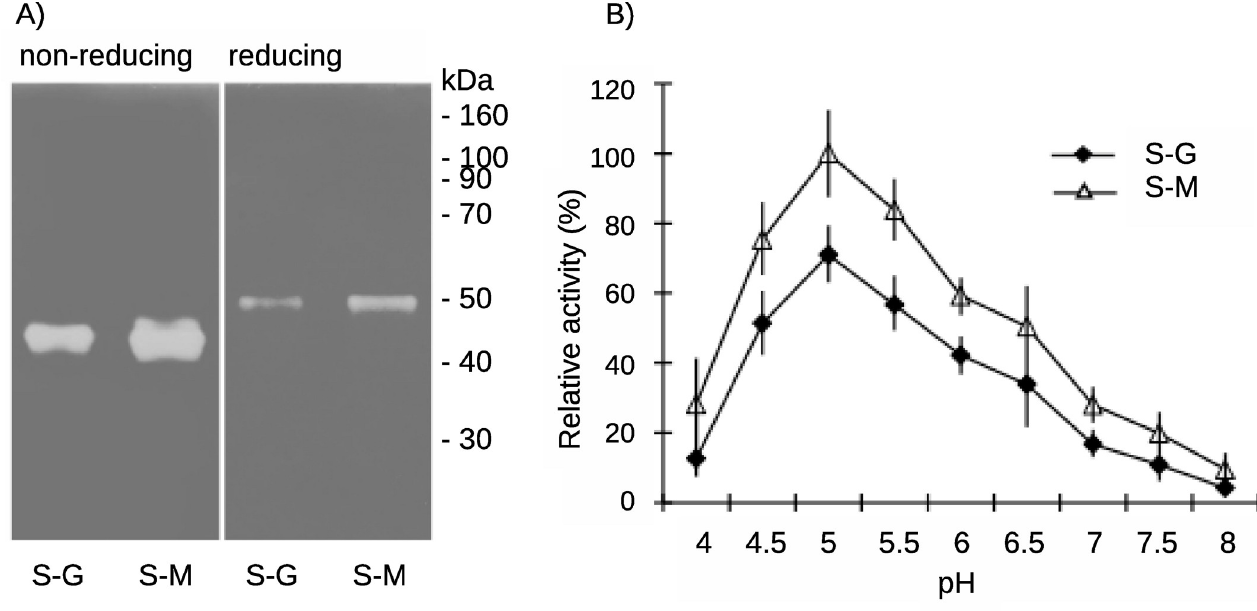
Fig 13. Visualization and comparison of the hyaluronidase activities in two S . schwetzi lineages maintained on different blood-meal sources, geckos (S-G) and mice (S-M). (A) Visualization and comparison by SDS PAGE zymography. SDS PAGE gel contained 10% polyacrylamide gel with incorporated 0.002% HA. SGHs of two S . schwetzi lineages maintained on different blood meal sources geckos (S-G) and mice (S-M) were tested under non-reducing and reducing conditions. (B) Comparison of the pH dependence of salivary hyaluronidase activity from S-G and S-M lineages. Results represent the mean ± SD of five independent measurements. The difference in relative activities for different buffer systems at pH 7 was lower than